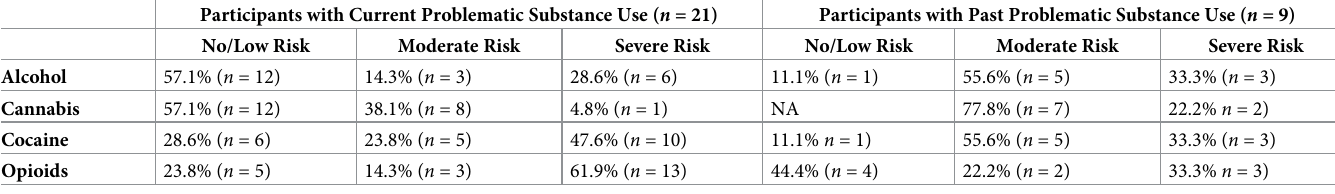
Table 2. WHO-ASSIST substance use risk category among key informant interview participants. Participants with Current Problematic Substance Use ( n =